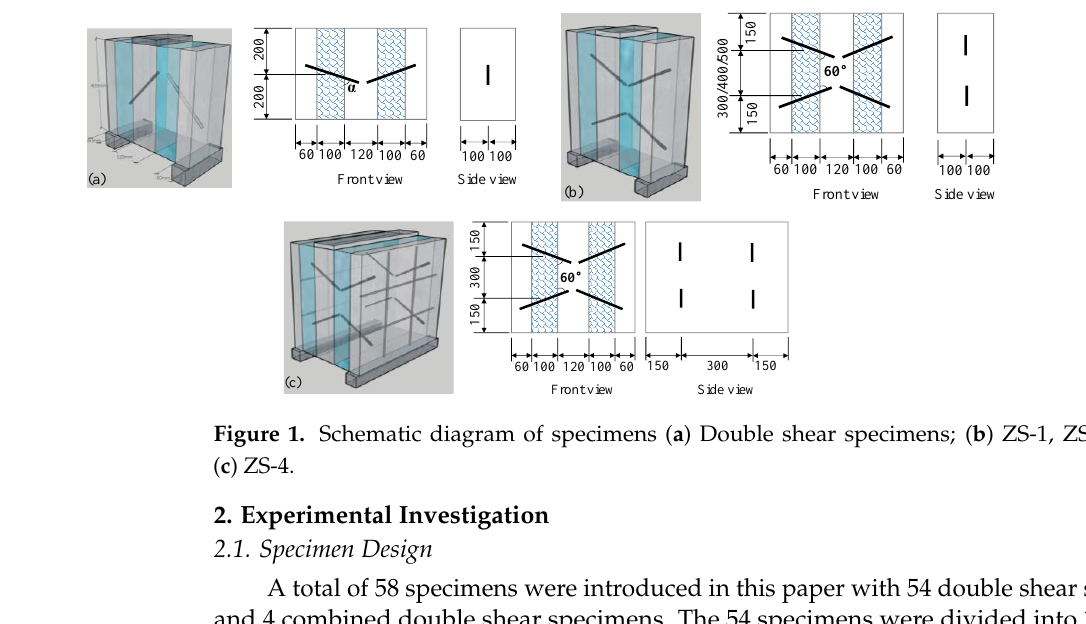
Table 1. Parameter of specimens.